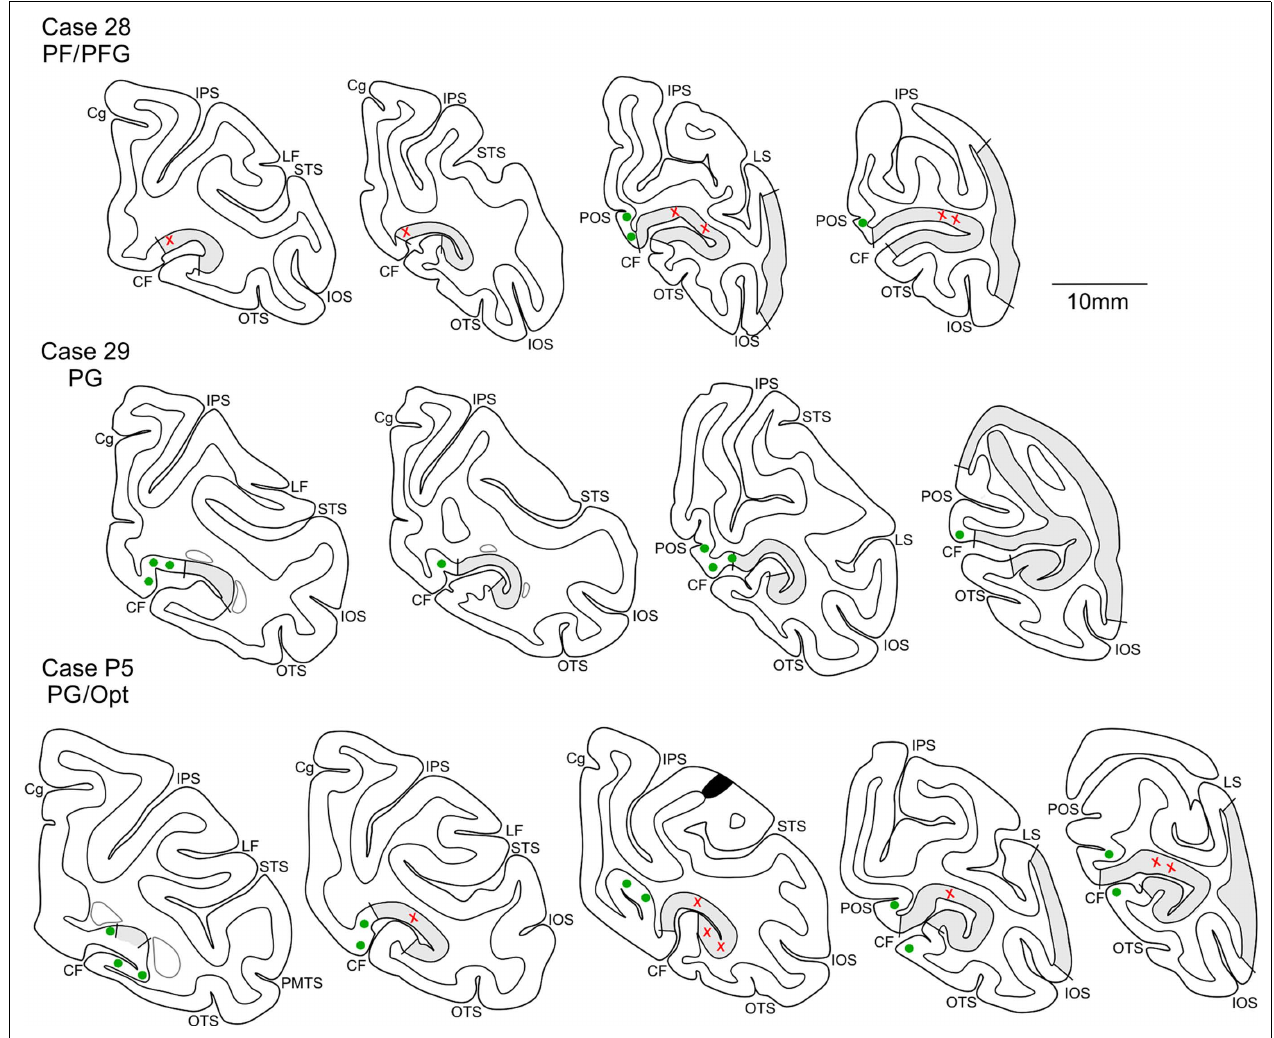
mark dorsal and ventral borders betweenV1 (gray shading) andV2. Black region in the third section of Case P5 indicates part of the injection site.The caudal extension of the lateral ventricle appears in gray, in the rostral sections. CF, calcarine fissure; Cg, cingulate sulcus; OTS, occipito-temporal sulcus; POS, parieto-occipital sulcus. Other abbreviations as in Figure 1